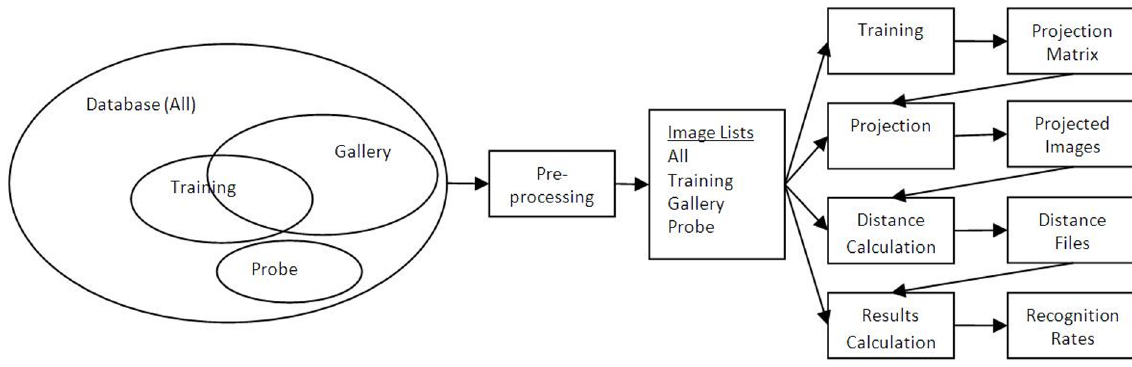
Figure 3. Basic Modules of Evaluation Methodology.